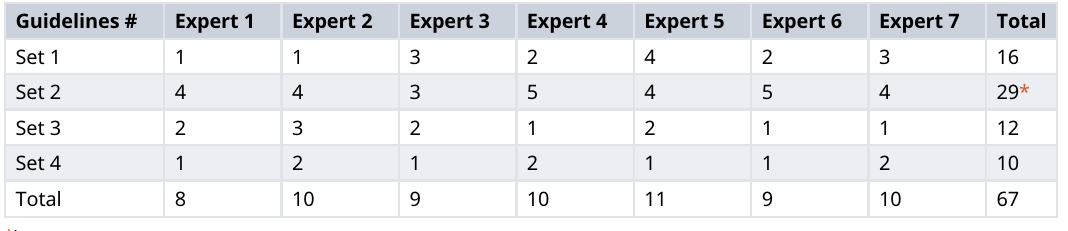
Table 3. Ranking of guidelines developed after phase 3 of nominal group